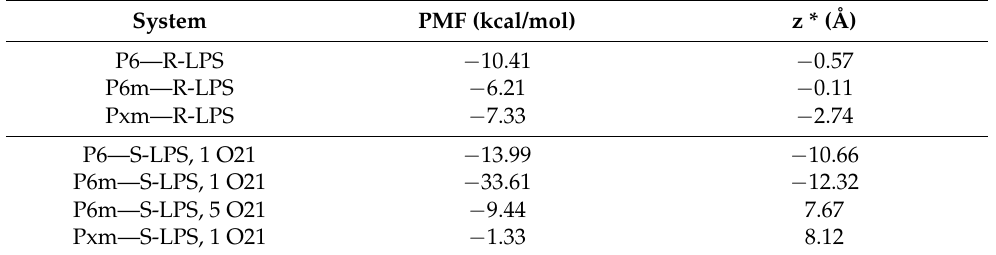
Table 2. Comparison of AMPs binding energy to E. coli OM with embedded OmpF